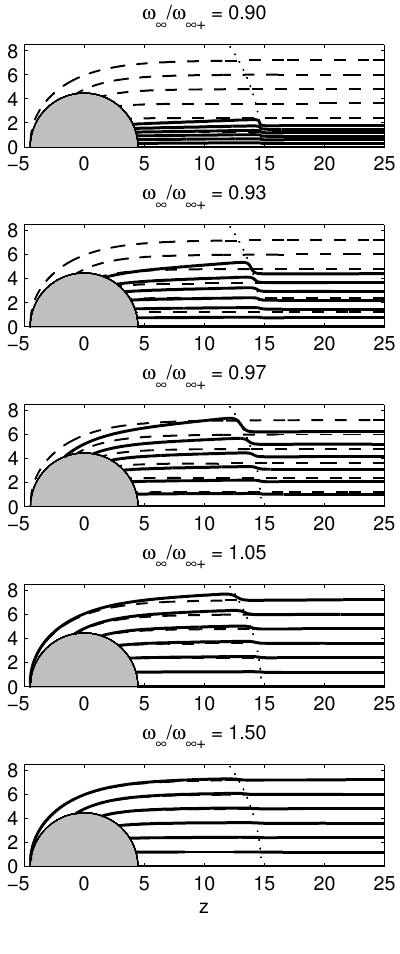
Figure 6. Trajectories of rays in the EW launched from the surface of the CO with frequency ratios ω ∞ / ω ∞ + = 0.90 ( top panel); 0.93 ( second panel) and 0.97 ( third panel); For rays higher than the EW, we also show the case for ω ∞ / ω ∞ + = 1.05 ( fourth panel) and 1.50 ( bottom